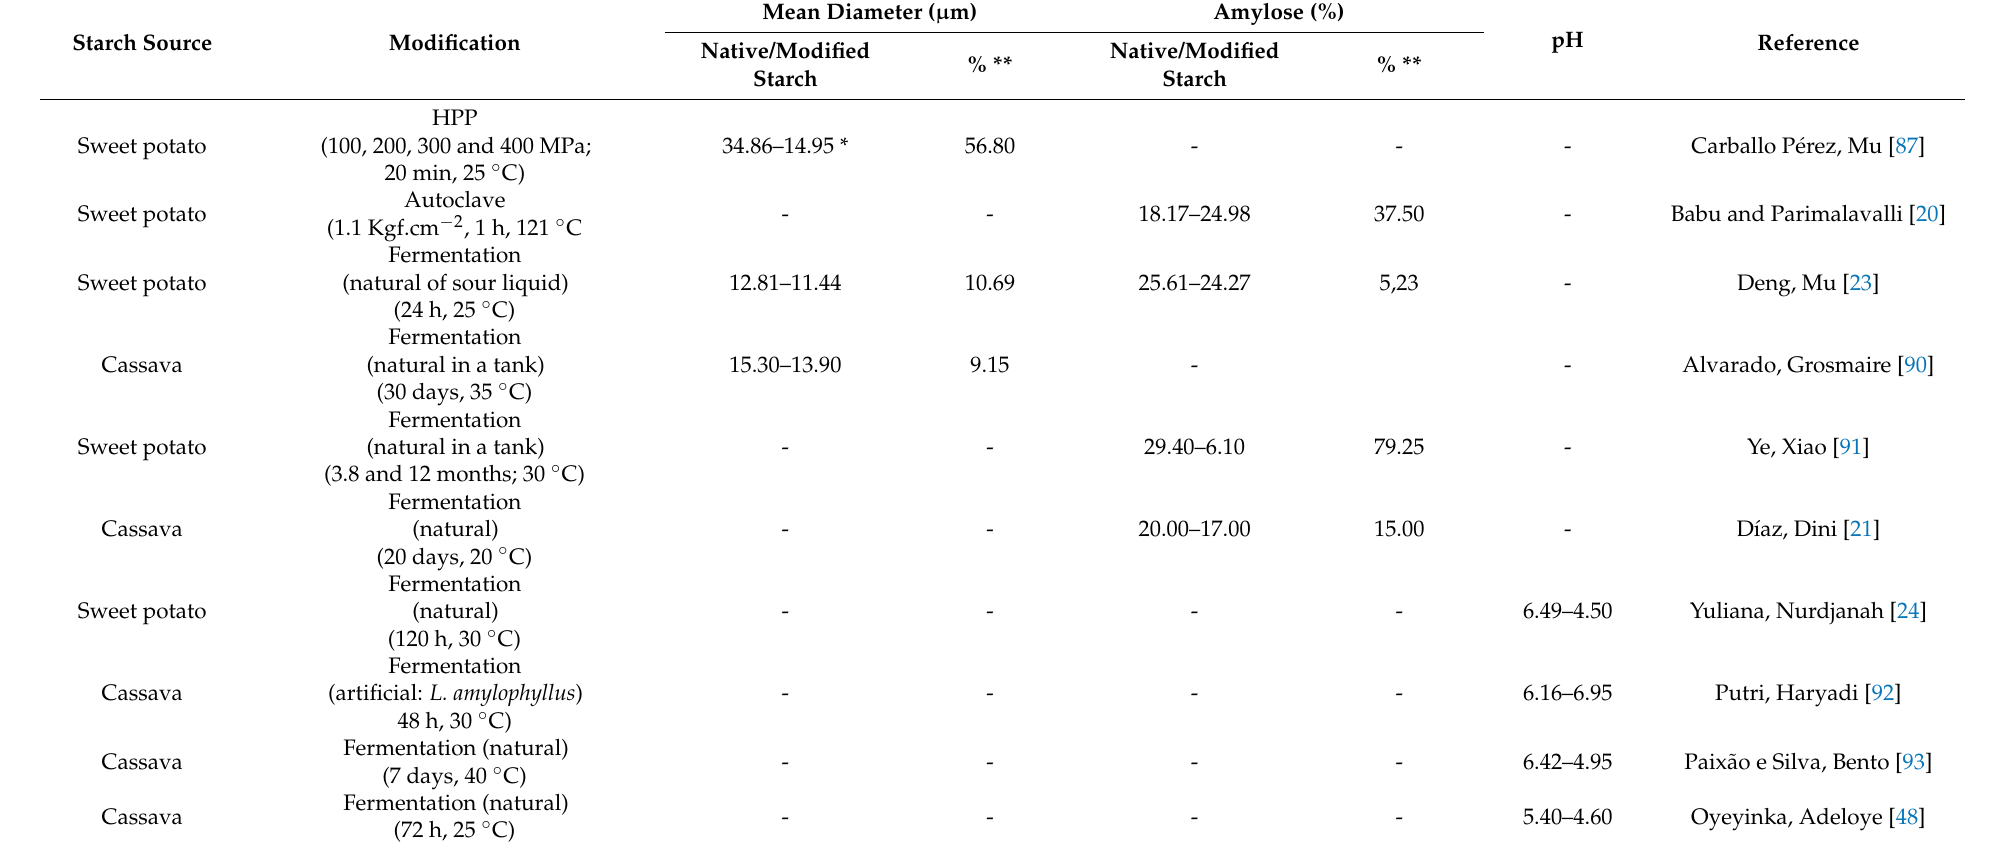
Table 1. Particle mean size of granules and amylose content of native and modified starches by high hydrostatic pressure (HPP), autoclave and fermentation, and pH of fermentation broth of native and fermented